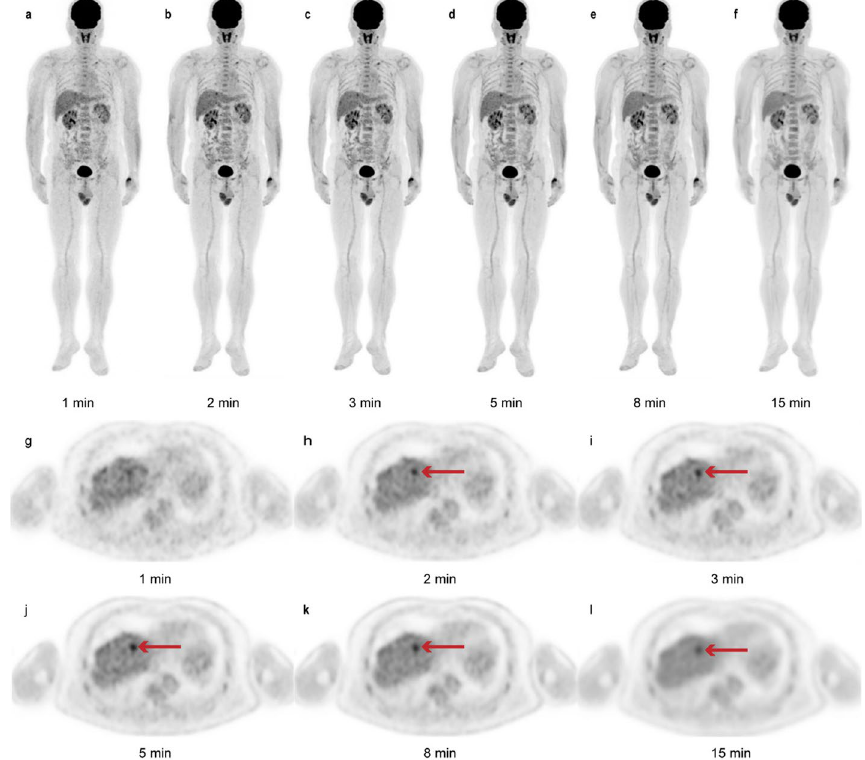
Fig. 3 A 56-year-old man with intrahepatic cholangiocarcinoma. The images show a lesion on G1 to G15 images with maximum intensity projection (MIP) ( a – f ) and the axial view ( g – l ). As indicated by the red arrowheads, the lesion is clearly identified on the G2, G3, G5, G8, and G15 images, but cannot be distinguished from background noise when the acquisition time is reduced to 1 min (G1